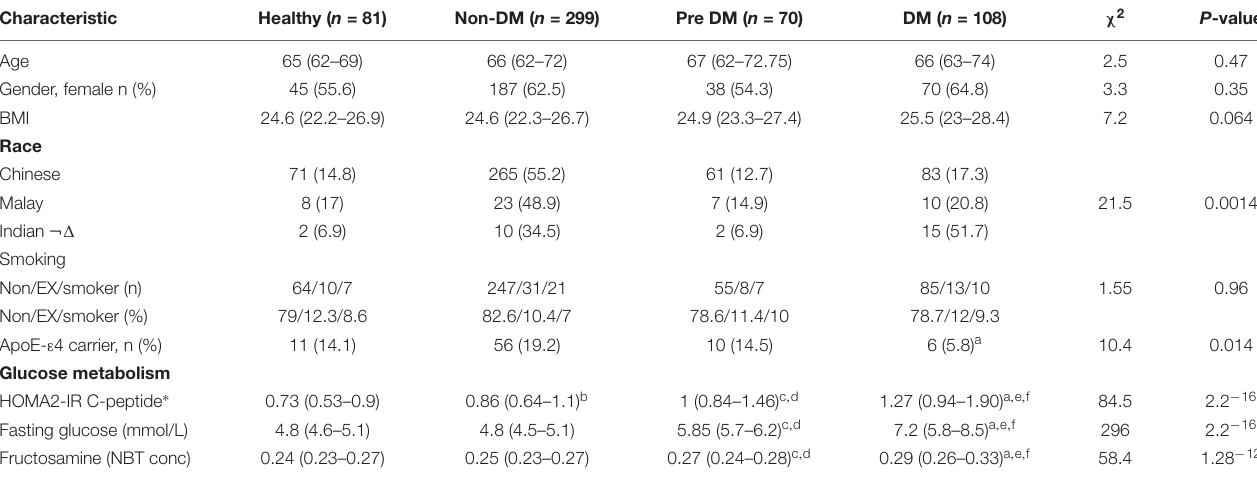
TABLE 1 | General socio-demographic